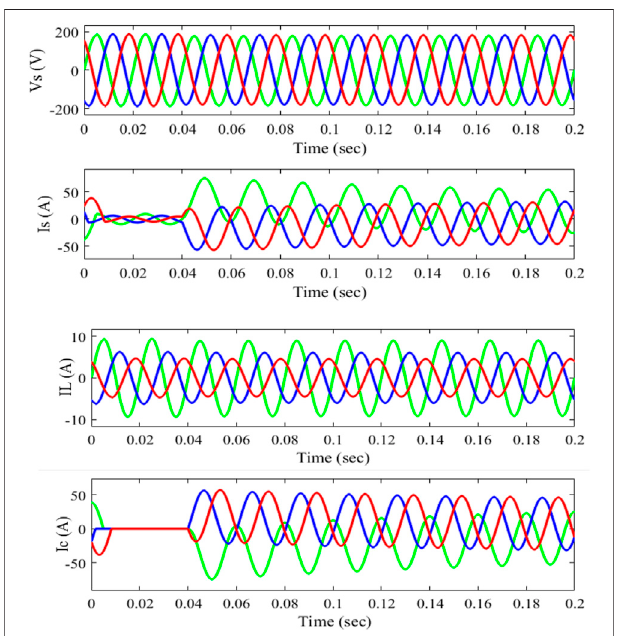
FIGURE 16 | With SHAPF for nonlinear load source voltage (V s ), source current (I s ), load current (I L ), and compensating current (I c ). FIGURE 14 | With the passive fi lter for unbalanced load source voltage